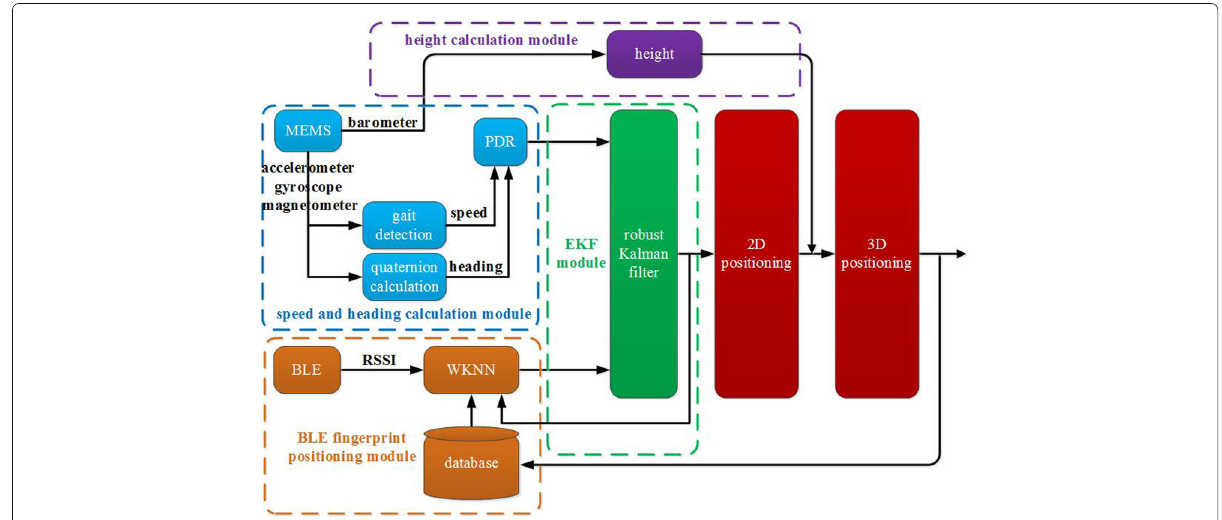
Fig. 1 Framework of BLE/MEMS fusion positioning system